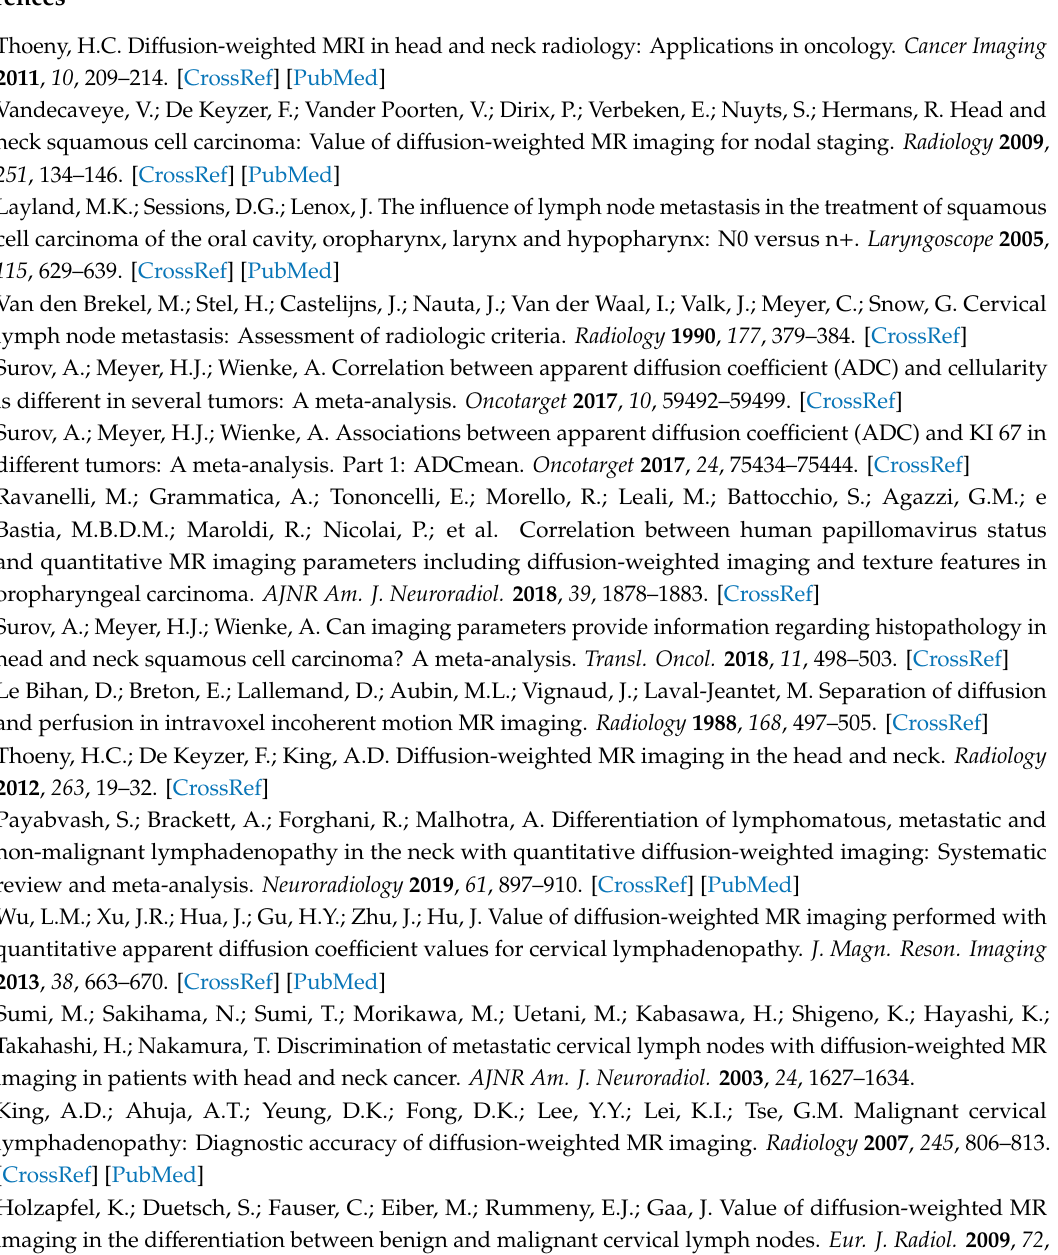
Table S1: Texture features analyzed in this study and their abbreviations, Table S2: Comparison of ADC texture features between benign and metastatic LNs of all sizes., Table S3: Comparison of ADC texture features between benign and metastatic subcentimeter-sized